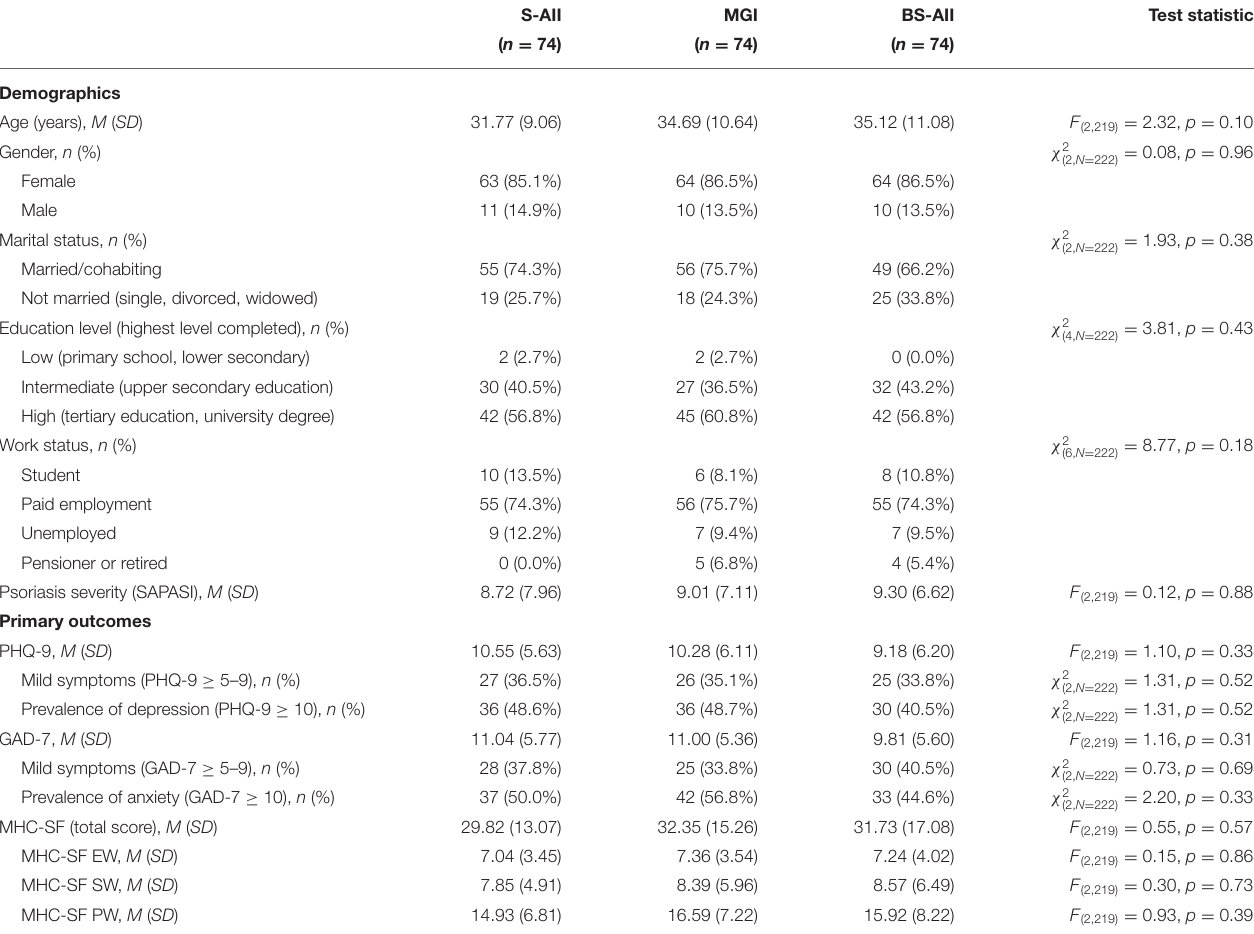
TABLE 1 | Baseline characteristics of the participants ( N =